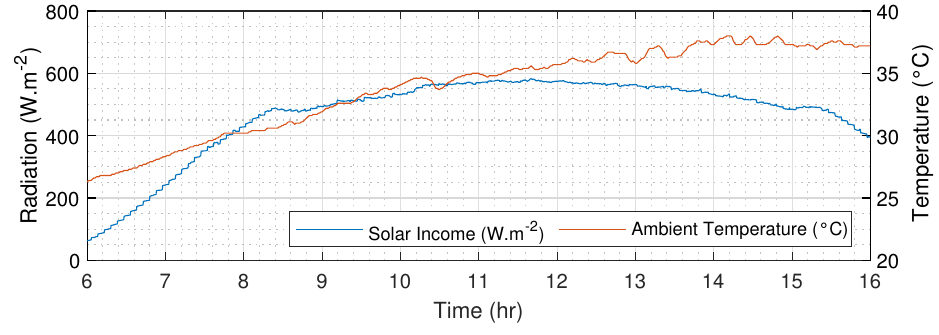
Figure 5. Outlet temperatures simulated, compared to the measured temperatures.